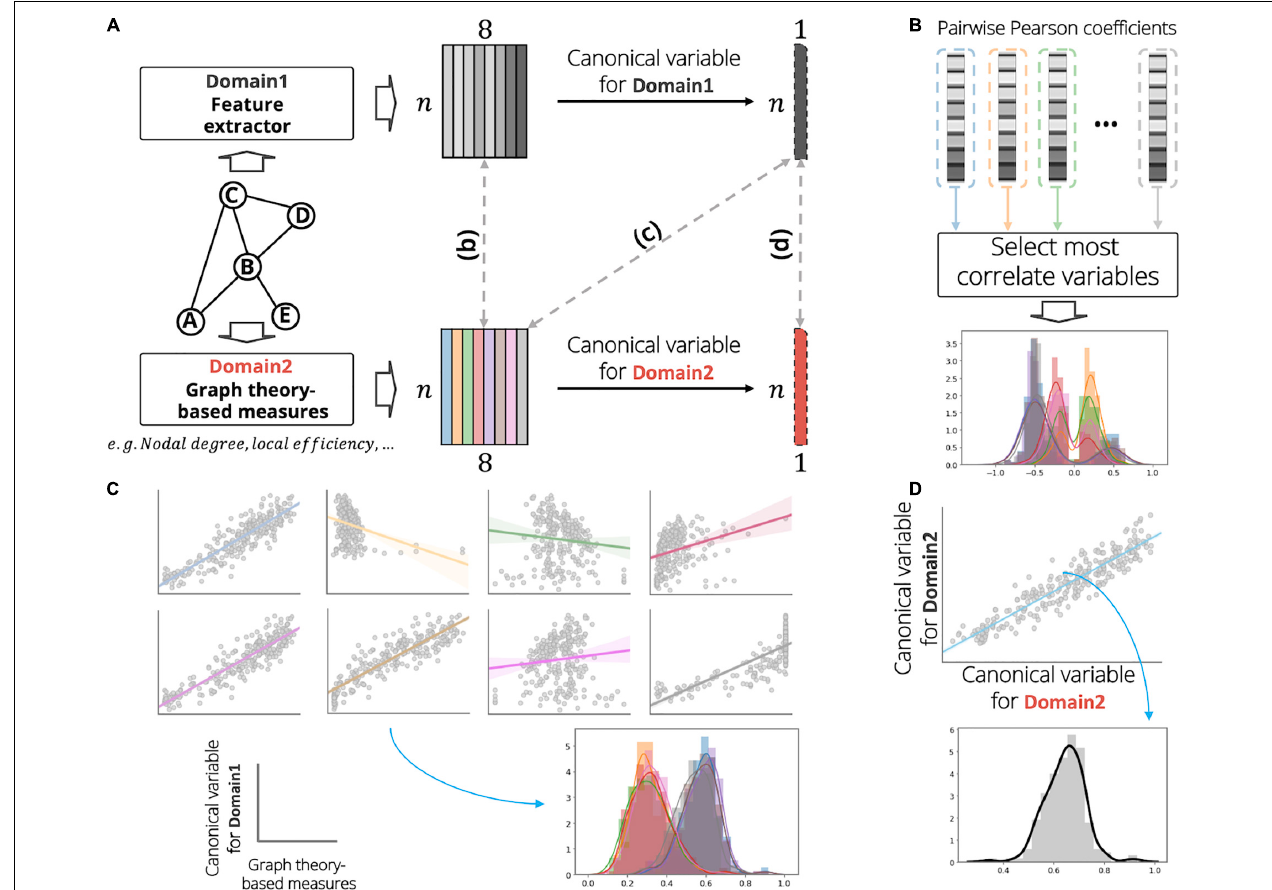
FIGURE 2 | Graphical illustration of analysis on investigating the relationship between the extracted features (domain 1) and graph theory-based nodal measurements (domain 2). (A) Example of the analysis for identifying association between a sample graph data (consisting of five nodes and five undirected-, and unweighted-edges). In this figure, the number of nodal measurements and the number of extracted features were set to eight. At each domain, we calculate a linear combination to obtain the canonical variables. (B) First, we calculate pairwise univariate Pearson correlation coefficients between domains and select a most correlation variable for each nodal measurement. (C) Second, we calculate the Pearson correlation coefficients between the canonical variable of domain 1 and the measurements of domain 2. (D) Last, we derive the Pearson correlation coefficient between the canonical variables among domains. In the distribution plot, x-axis and y-axis indicate the correlation value and corresponding density, respectively. In the scatter plot of panel (C) , gray circles, solid lines, and shaded region demonstrate subject samples, linear regression line, and standard error for all samples,